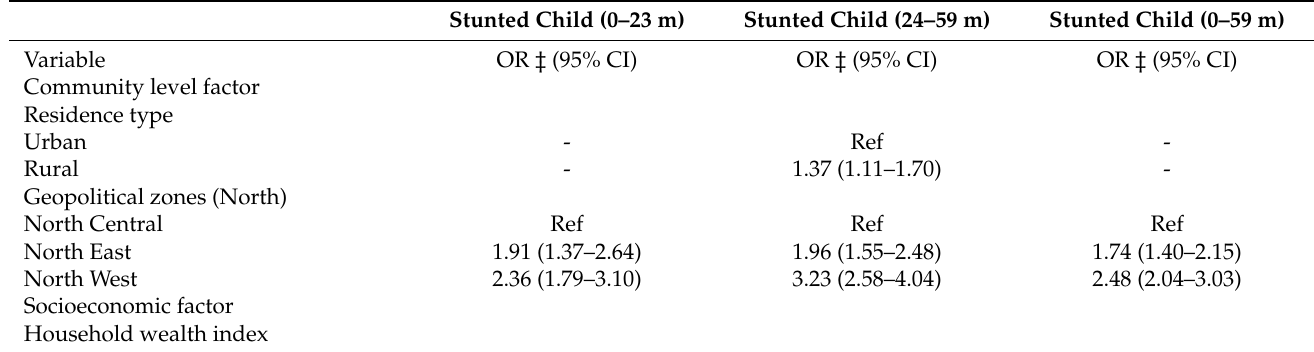
Table 2. Adjusted ORs (95% CI) for independent variables significantly associated with stunted children aged 0–23 m, 24–59 m, and 0–59 m in NGZs, Nigeria